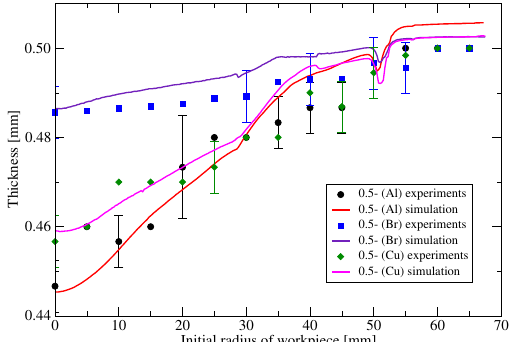
Figure 12. Thickness variation of the deformed 0.5 mm stacked metal sheets of Al, Cu and Br materials with respect to the initial radius of the workpiece.